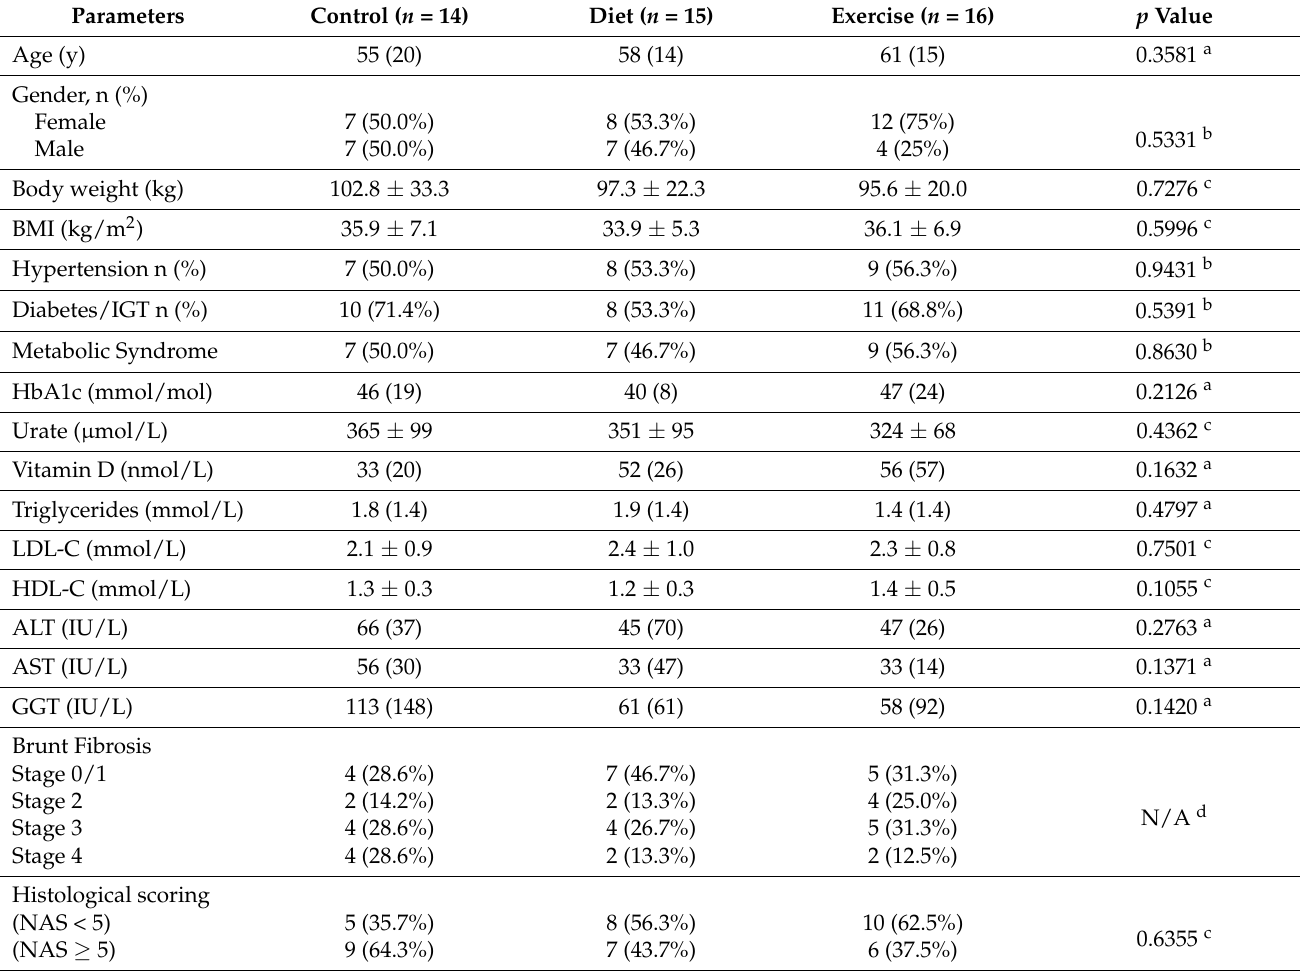
Table 1. Baseline clinical and laboratory